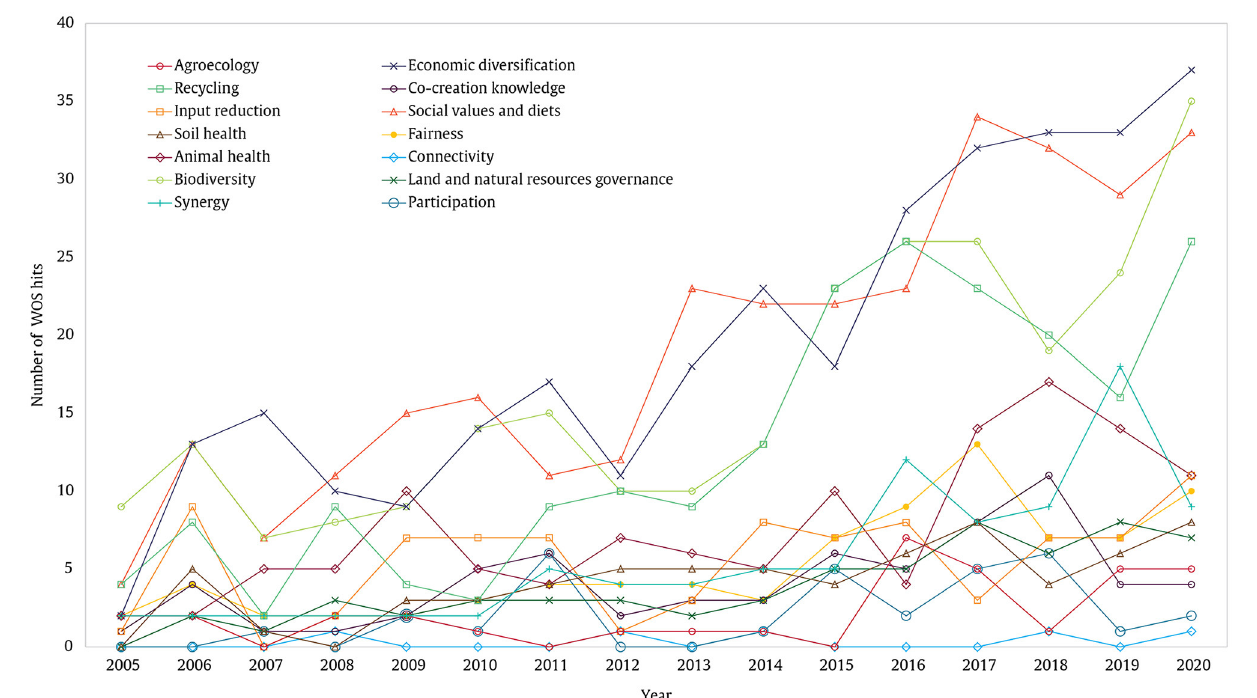
FIGURE 3 | Evolution of the interest of the scientific community for the different nexi between forages and principles.